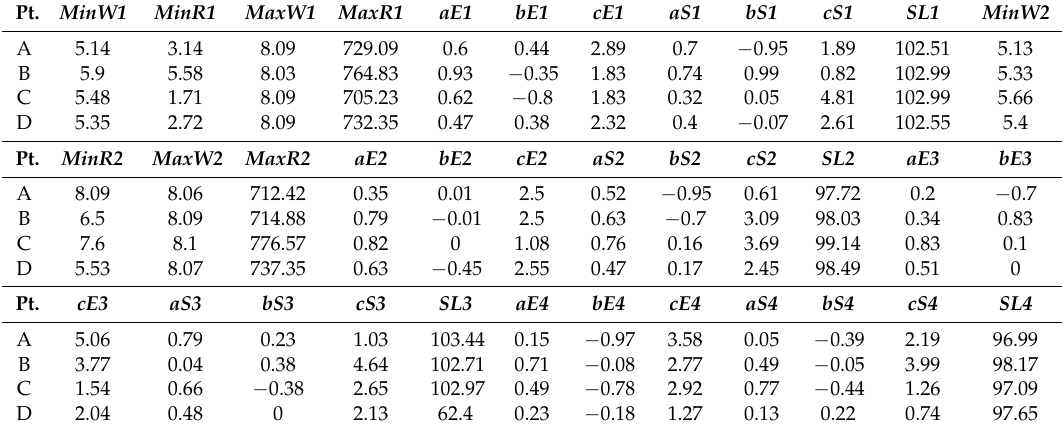
Table 2. Decision variables of points of A, B, C, and D of the year with 75% frequency.